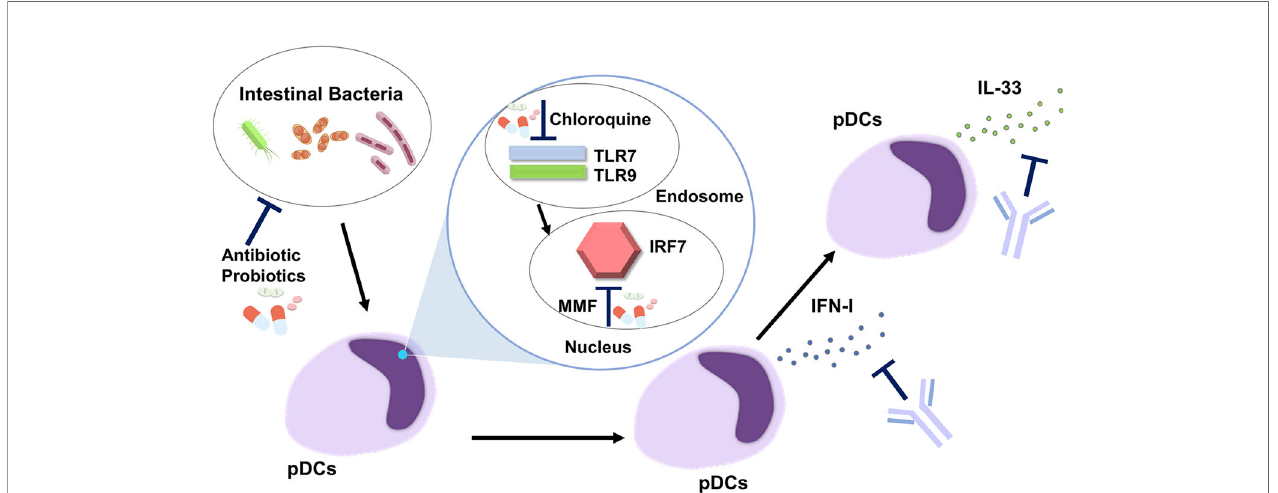
FIGURE 2 | Development of new treatments targeting the plasmacytoid dendritic cell-IFN-I-IL-33 axis in autoimmune pancreatitis and IgG4-related disease. Intestinal dysbiosis activates endosomal Toll-like receptor 7 (TLR7) and TLR9 followed by nuclear translocation of IFN regulatory factor 7 (IRF7). pDCs produce IFN-I through the nuclear translocation of IRF7. IL-33 is produced by pDCs in an IFN-I-dependent manner. Antibiotics and probiotics may be useful for correction of intestinal dysbiosis. Chloroquine inhibits the activation of endosomal TLR7 and TLR9. Mycophenolate mofetil (MMF) suppresses nuclear translocation of IRF7. IFN-I-mediated signaling pathways are ef fi ciently inhibited by Abs against IFN-I or IFN-I receptor. An anti-ST2 Ab, neutralizing the IL-33 receptor, blocks IL-33-mediated signaling